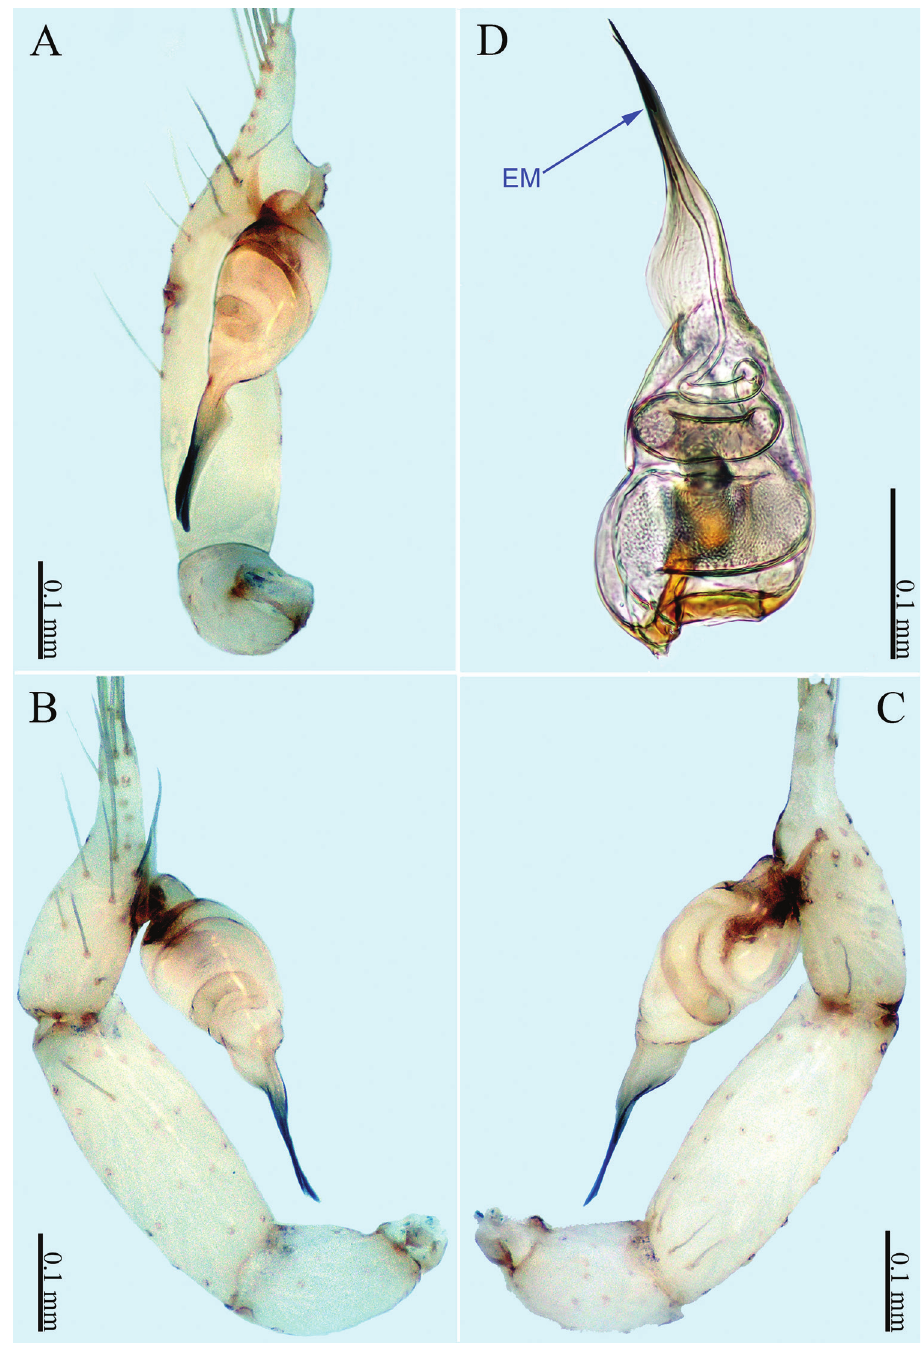
Figure 7. Sinoderces dewaroopensis Li & Li, sp. nov., right pedipalp of male holotype A palp, ventral view B palp, prolateral view C palp, retrolateral view D palpal bulb, ventral view. Abbreviation: EM